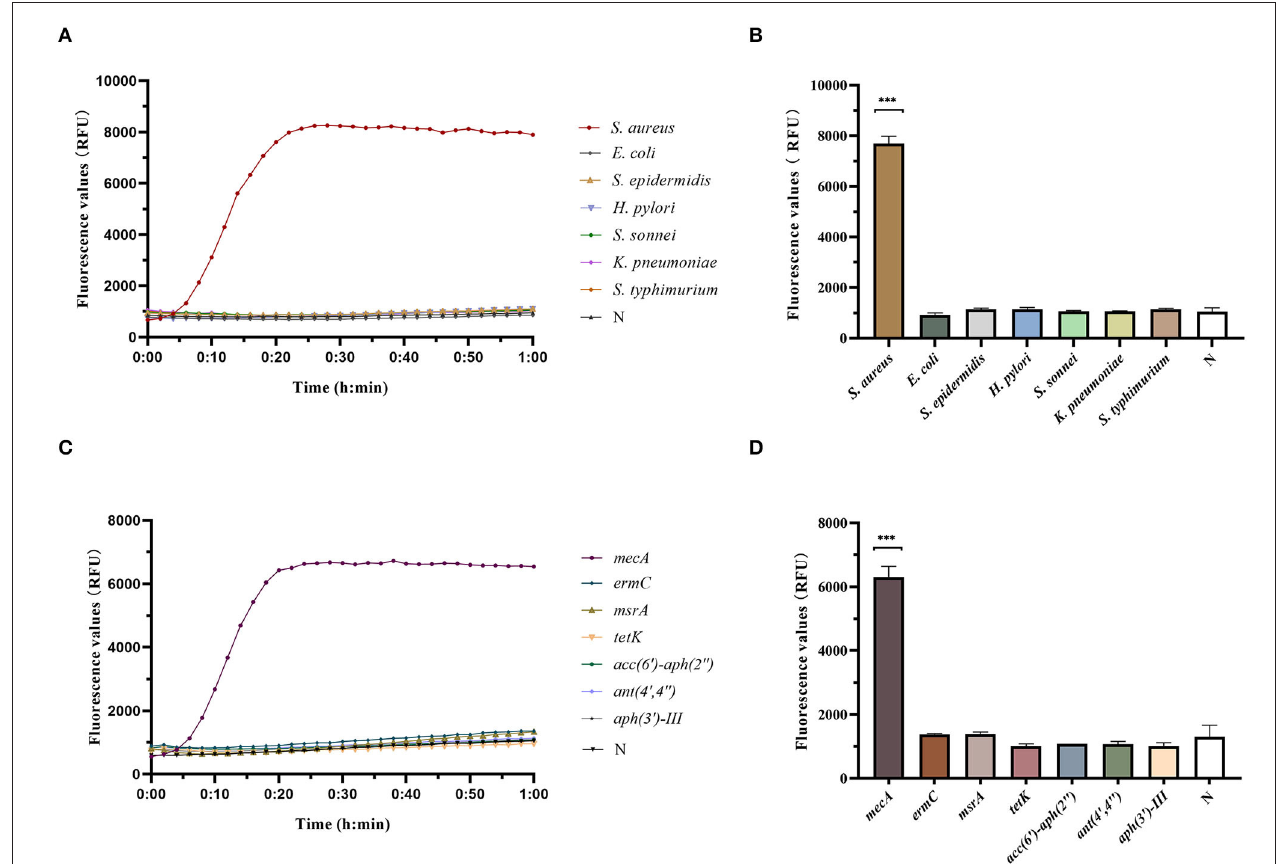
FIGURE 4 | Determination of specificity of RAA-Cas12a detection system. Data were expressed as mean ± SD ( n = 3). Negative control (N) utilized RNase-free water as input instead of DNA dilutions. *** p < 0.0001. (A) Fluorescence curves were generated when different clinical strain samples were detected by the RAA-Cas12a detection system. (B) Cas12a reaction was performed after 60min to compare the fluorescence values of different clinical strain samples. (C) Fluorescence curves were generated when different antibiotic resistance genes were detected by the RAA-Cas12a detection system. (D) Cas12a reaction was performed after 60min to compare the fluorescence values of different antibiotic resistance